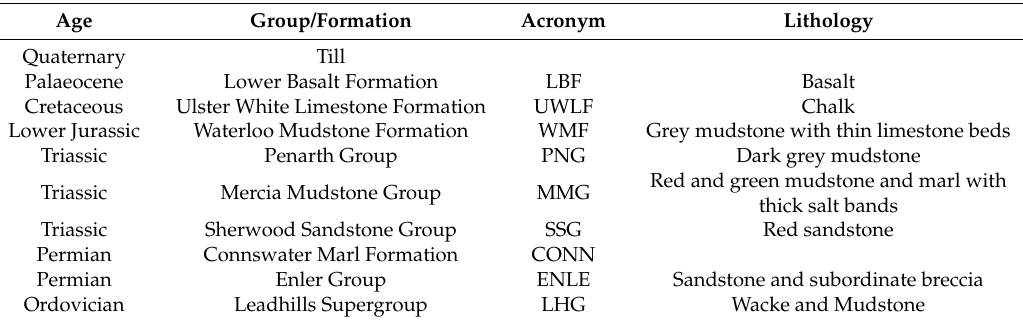
Table 6. Reference summary geology for the Belfast area.